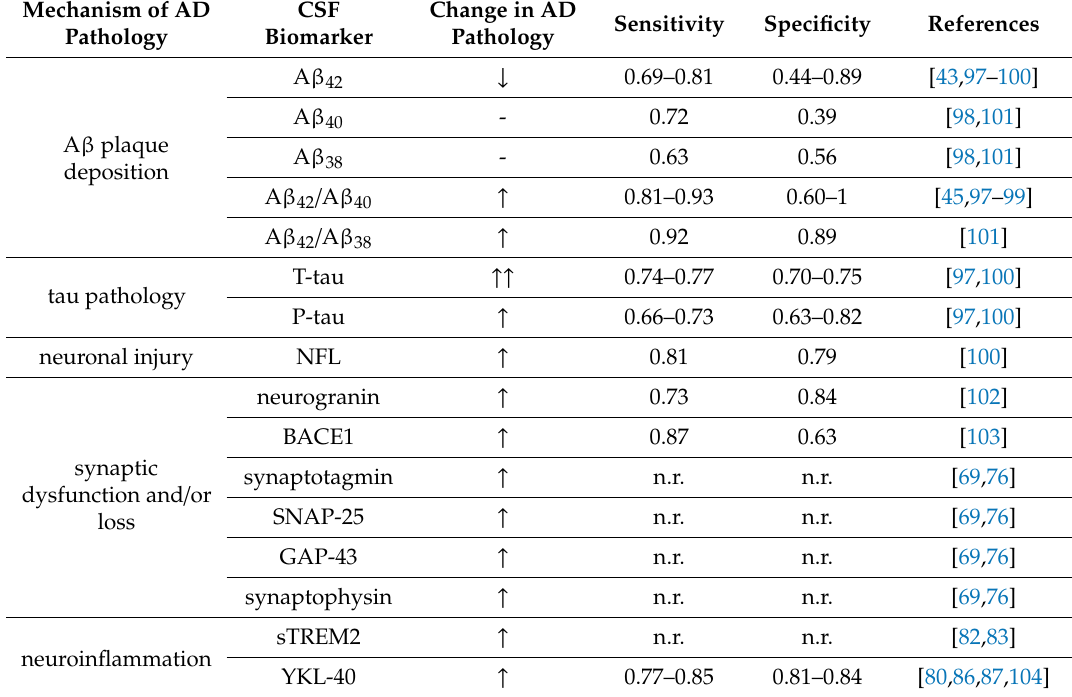
Table 1. The major changes of the identified CSF biomarkers for AD and the associated mechanisms of